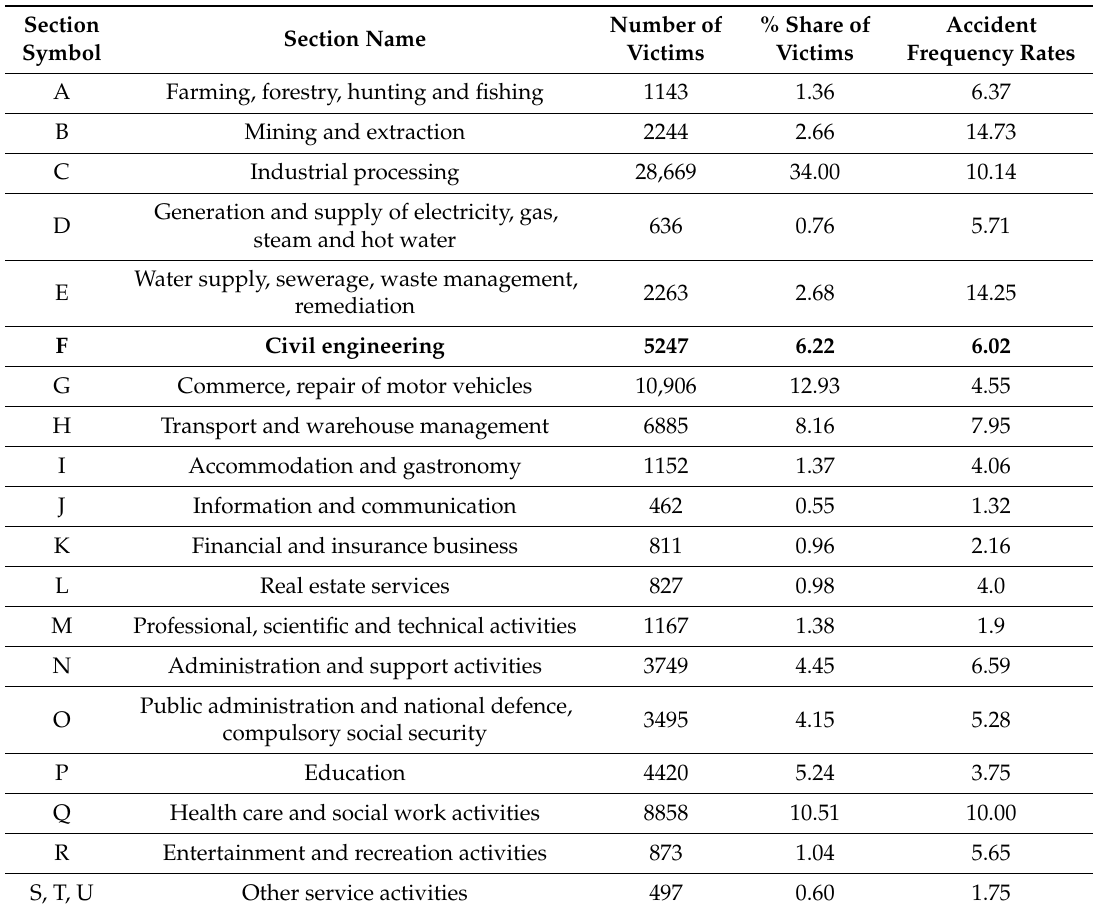
Table 1. Number of injured people and frequency of workplace accidents in specific sectors of the Polish national economy in 2018